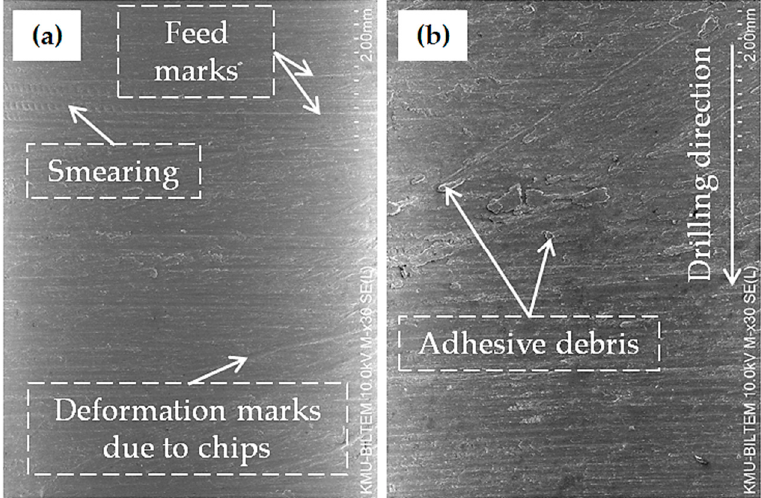
Figure 9. Hole surface damage analysis of AA2024-T3: ( a ) 6 mm drill bit and ( b ) 10 mm drill bit.